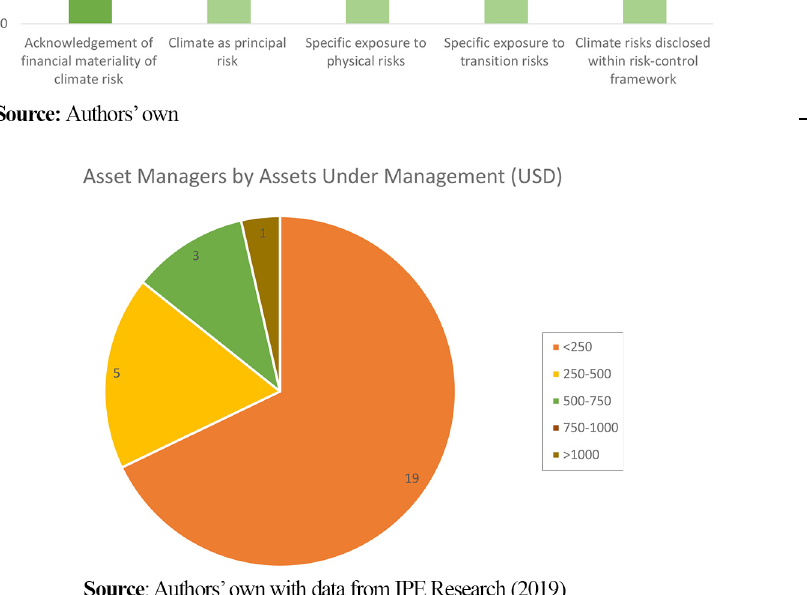
Figure 2. Graph showing different disclosure techniques among